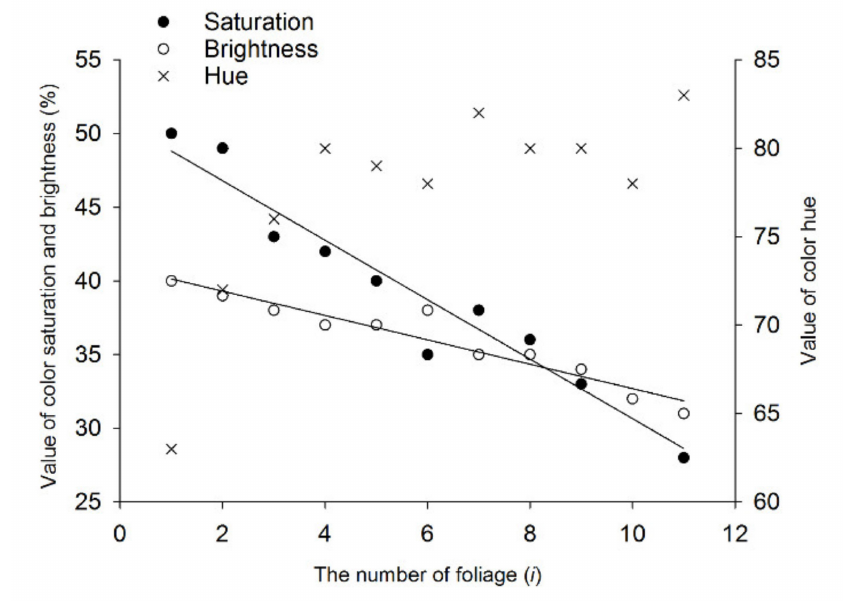
Figure 5. HSB parameters of tea leaves of di ff erent ages: On the obverse side of each leaf, on a total of six di ff erent branches, four sampling points were selected and measured. H , S , and B are foliage color hue (0–359), saturation (0–100), and brightness (0–100), respectively. The leaves of di ff erent ages are numbered with i ( i = 1–11) from the top to bottom of a tea shoot (see Figure 1). Regression analysis of parameters S and B was conducted, with i regarded as an independent variable, to clarify the variation tendency of the two parameters with changing leaf